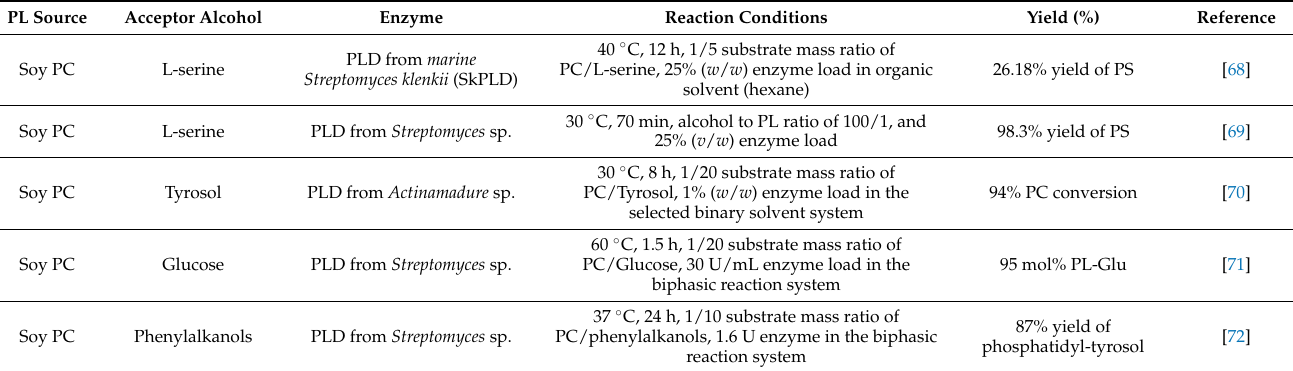
Figure 9. PLD−mediated transphosphatidylation to prepare phosphatidyl serine ( e ), phosphatidylinositol ( f ), phosphatidyl glycerol ( g ), and phosphatidyl ethanolamine ( h ) from PC and L−serine ( a ), myo − inositol ( b ), glycerol ( c ), and ethanolamine ( d ). Table 4. PLD-mediated of SPLs production.